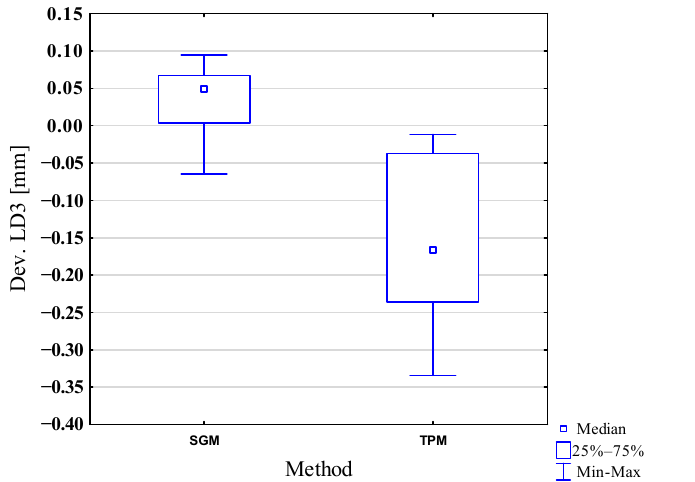
Figure 5. Comparison of deviations of the linear dimension 3 for SGM and TPM methods.